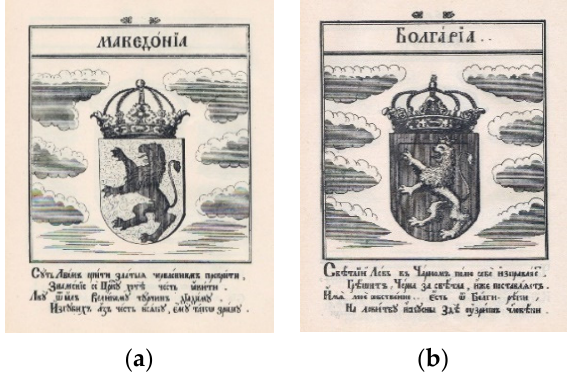
Figure 22. ( a ) CoA of Macedonia from the Stematographia by Vitezovich. ( b ) CoA of Bulgaria from the Stematographia by Zhefarovich